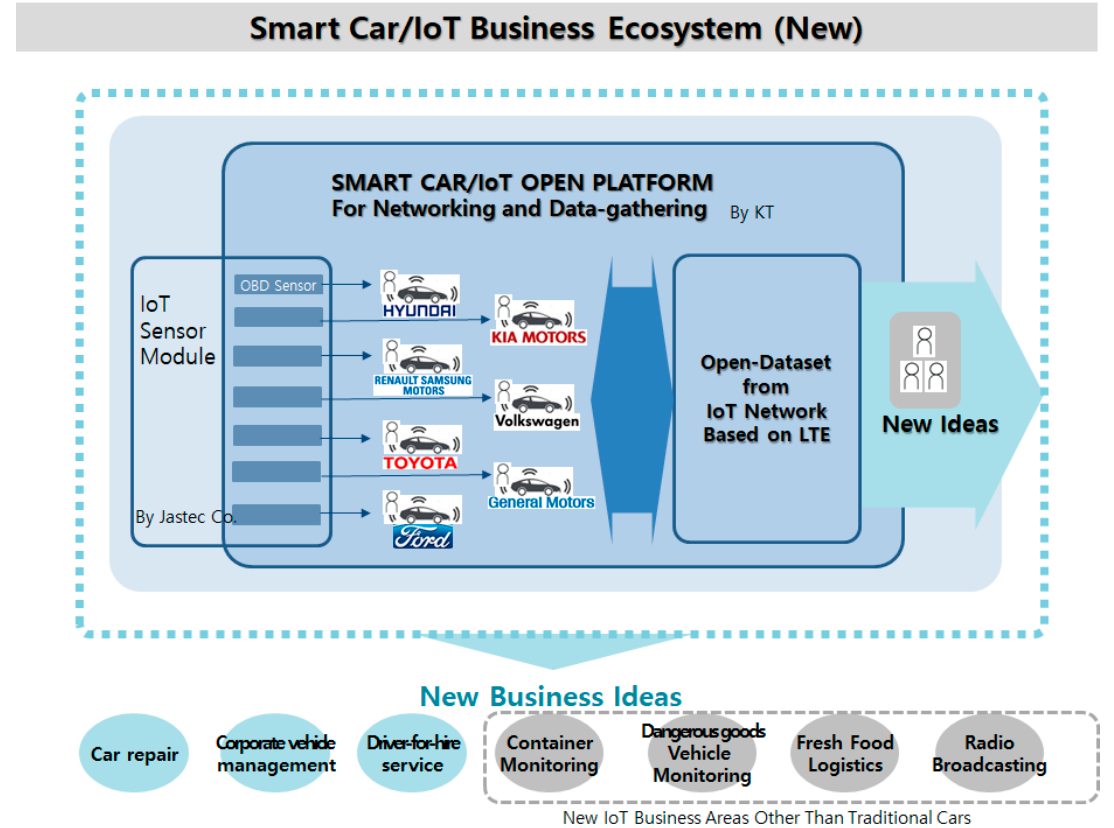
Figure 5. New Smart Car/IoT business ecosystem due to the Flagship Project Support Program (FPSP)